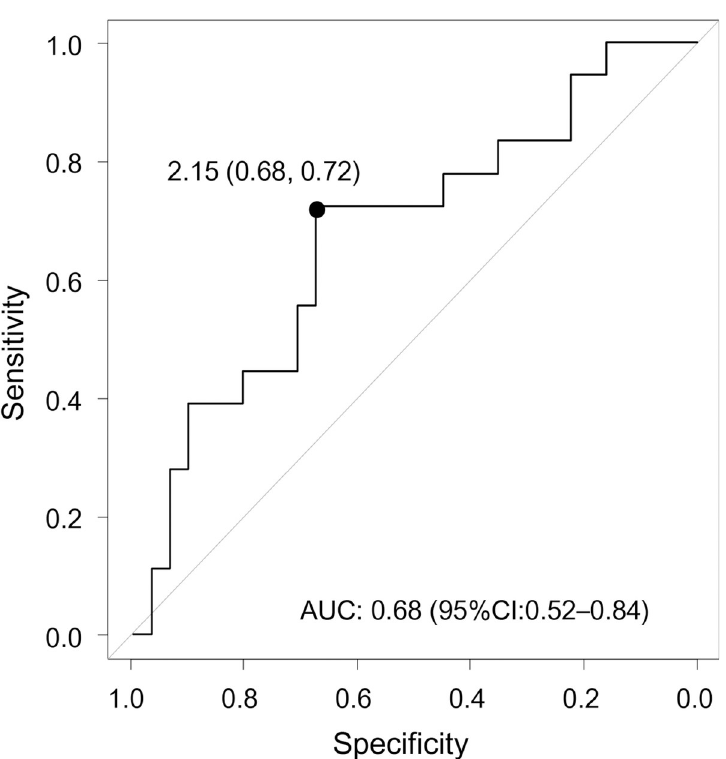
Fig 2. Receiver operating characteristic curve for determining the cutoff value of the neutrophil-to-lymphocyte ratio (NLR) for predicting the development of pouchitis. The optimal cutoff value for the NLR determined by maximal Youden’s index was 2.15 (specificity: 67.7%, sensitivity: 72.2%). Area under curve (AUC): 0.68 (95% confidence interval [CI]: 0.52–0.84).